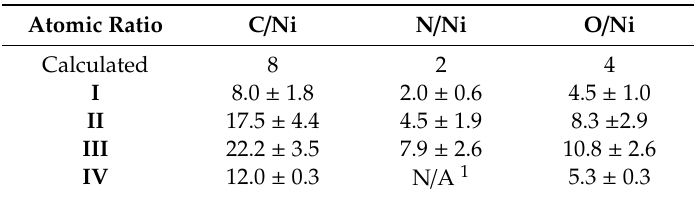
Table 1. EDX elemental analysis of samples I – IV .